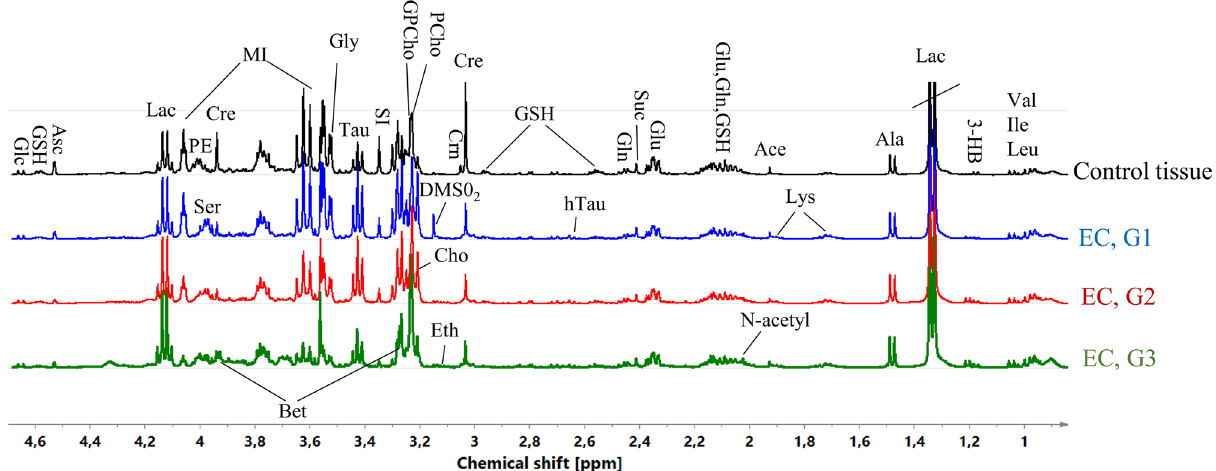
Figure 2. Average 1 H HR-MAS NMR CPMG spectra obtained from the G1, G2 and G3 endometrial tumors and the healthy endometrium. The assigned signals: Val valine, Ile isoleucine, Leu leucine, 3-HB 3-hydroxybutyrate, Lac lactate, Ala alanine, Ace acetate, Glu glutamate, Gln glutamine, GSH glutathione, Lys lysine, N-acetyl N -acetyl compound, hTau hypotaurine, Suc succinate, Cre creatine, Crn creatinine, PCho phosphocholine, GPCho glycerophosphocholine, Cho choline, DMSO 2 dimethyl sulfone, Eth ethanolamine, SI scyllo-inositol, Tau taurine, Gly glycine, MI myo-inositol, PE phoshoethanolamine, Ser serine, Bet betaine, Asc ascorbate, Glc glucose. The image was created using SIMCA-P 15.0 software package (https:// www. sarto rius. com).